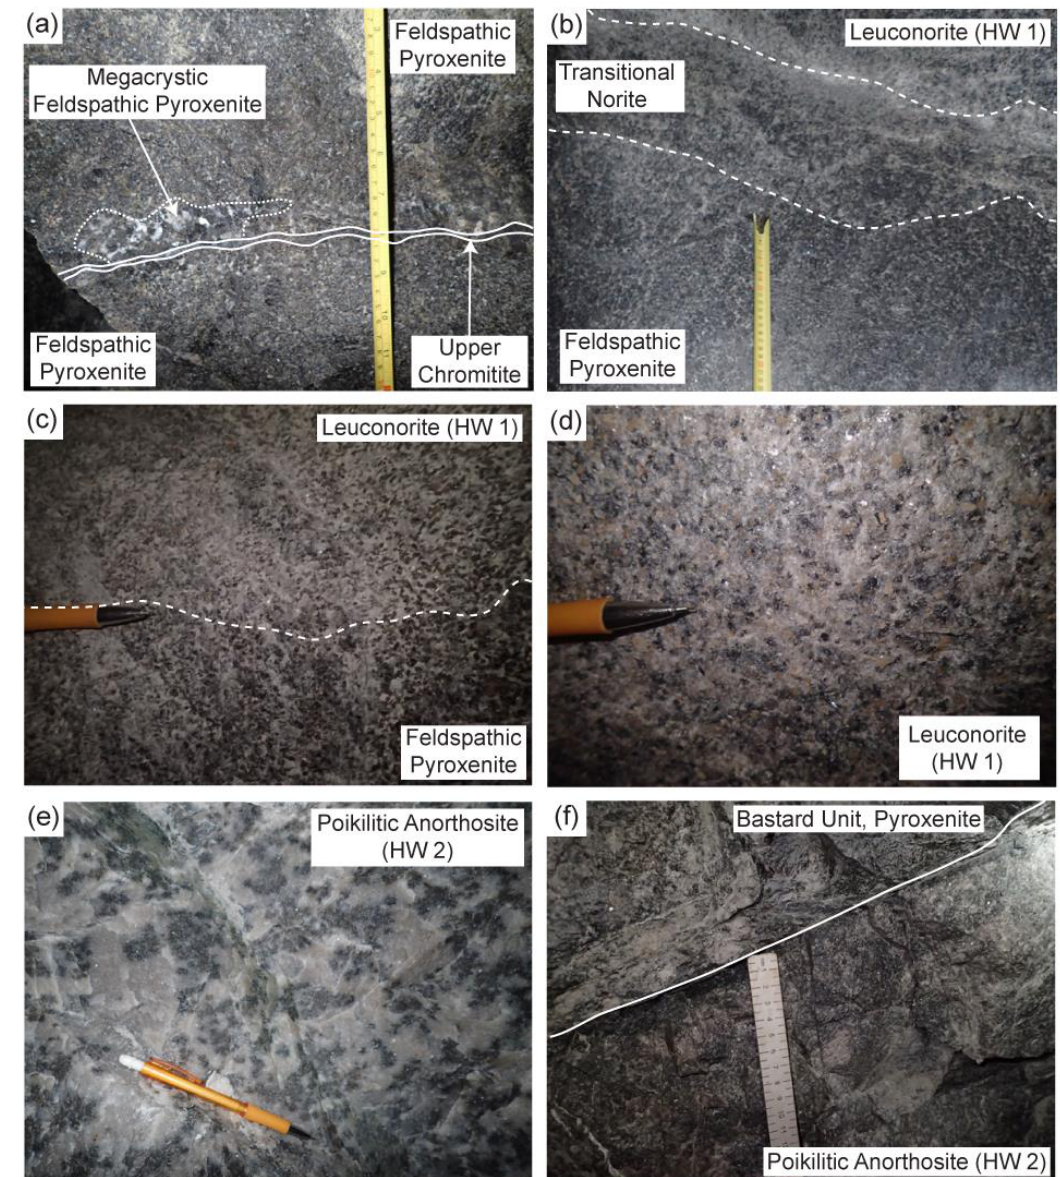
Figure 5. ( a ) Upper chromitite within the feldspathic orthopyroxenite, with patches of megacrystic feldspathic orthopyroxenite; ( b ) Gradational contact between feldspathic orthopyroxenite, transitional norite and hanging wall leuconorite; ( c ) Gradational contact between feldspathic orthopyroxenite and hanging wall leuconorite; ( d ) HW 1, “spotted” leuconorite; ( e ) HW 2, “mottled” poikilitic anorthosite; ( f ) Sharp contact between HW 2 and the Bastard Unit pyroxenite marked by a serpentinised shear zone; for scale, the pencil is 14 cm long.